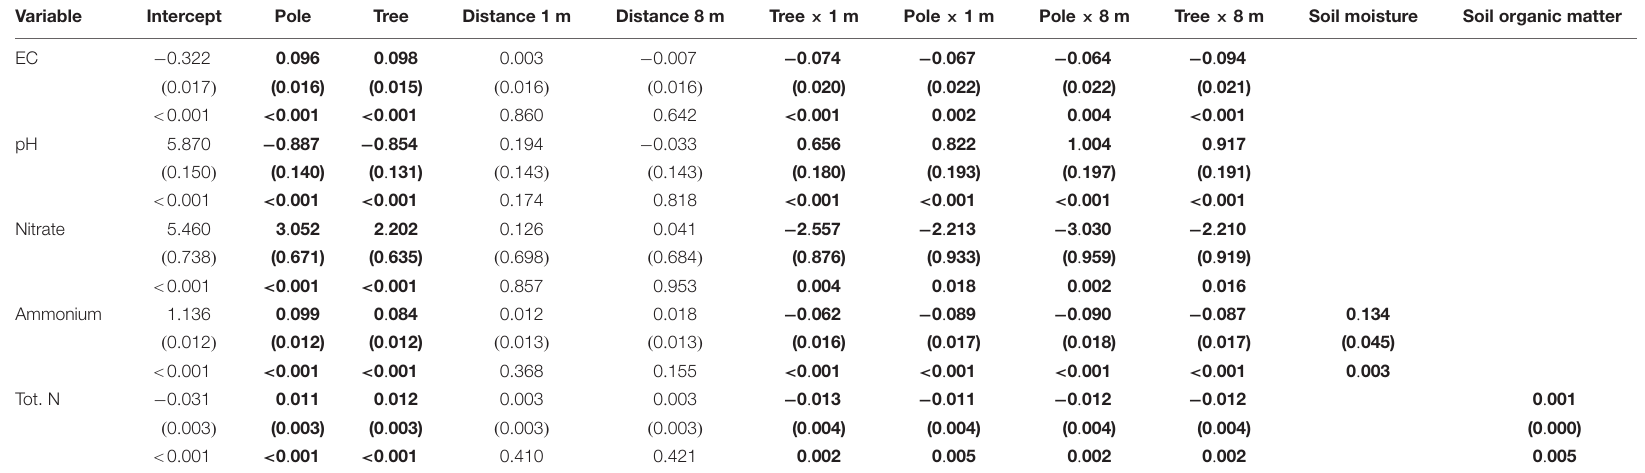
TABLE 1 | GLMM results, testing the effects of treatment (a factor with three levels; grass, pole, tree), distance (a factor with three levels; 0, 1, and 8 m), and their two-way interaction on five variables (pH, EC, nitrate, ammonium, and tot. nitrogen). Variable